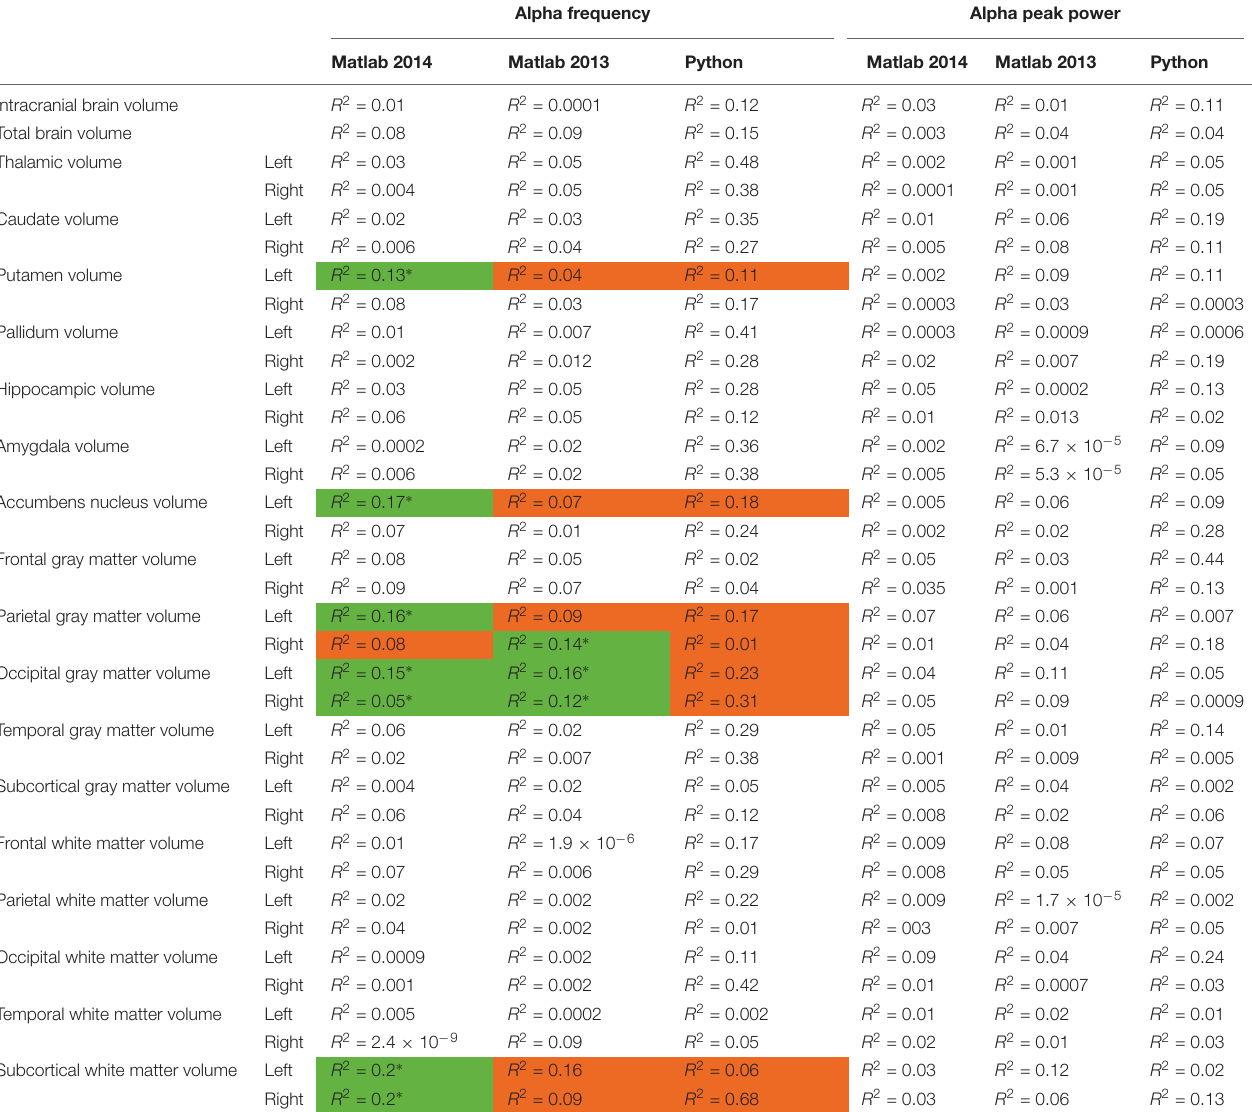
TABLE 4 | Bivariate regression analysis regarding the association between alpha characteristics (frequency and power) analyzed with Matlab 2014, Matlab 2013, and Python related to neuroanatomic